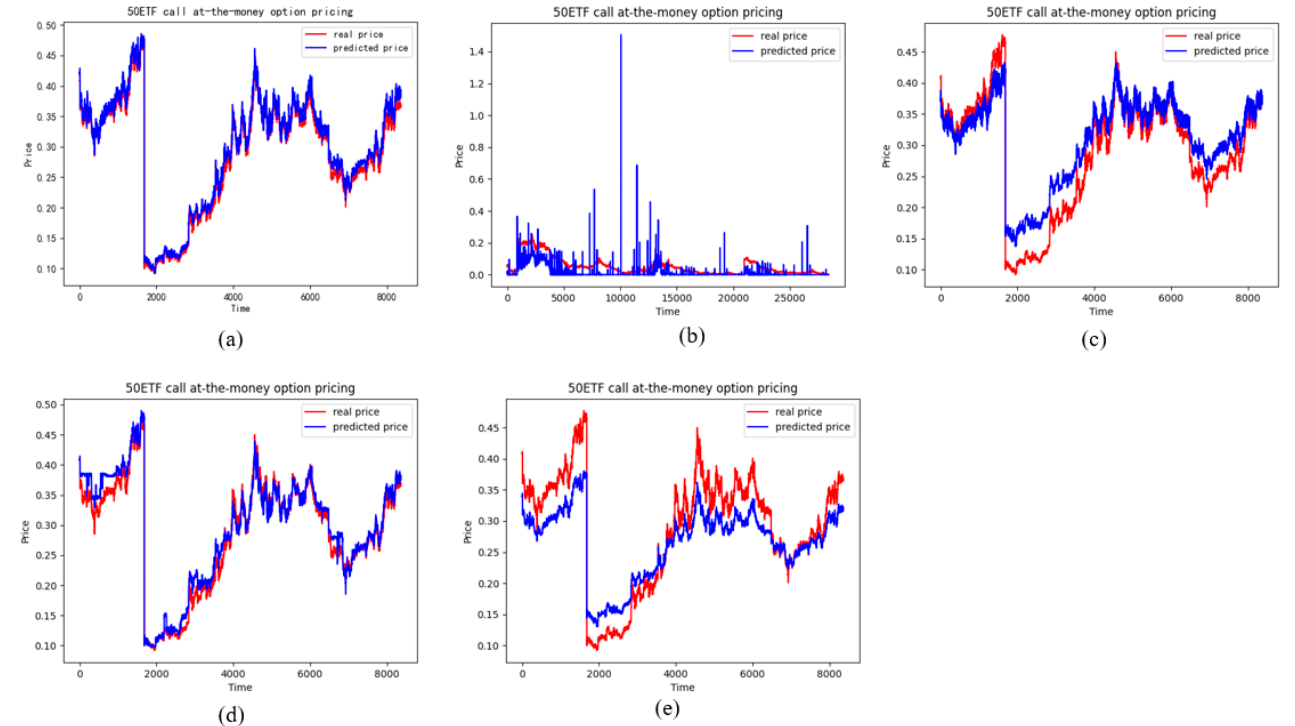
Figure 14. The pricing performance of ATM call options on each model ( a ) stands for the LSTM model, ( b ) stands for the BS model, ( c ) stands for the SVM model, ( d ) stands for the Random forests model, ( e ) stands for the RNN model.